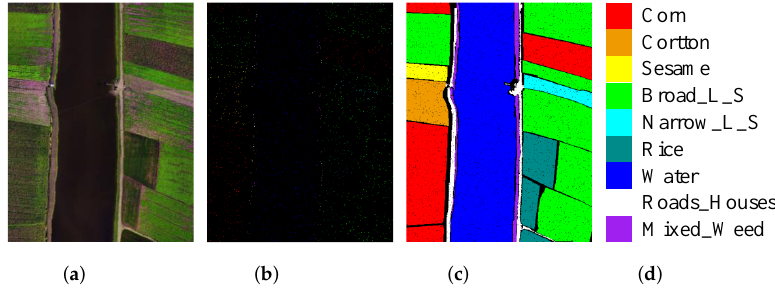
Figure 6. LK dataset. ( a ) Composite image. ( b ) Training set. ( c ) Test set. ( d )